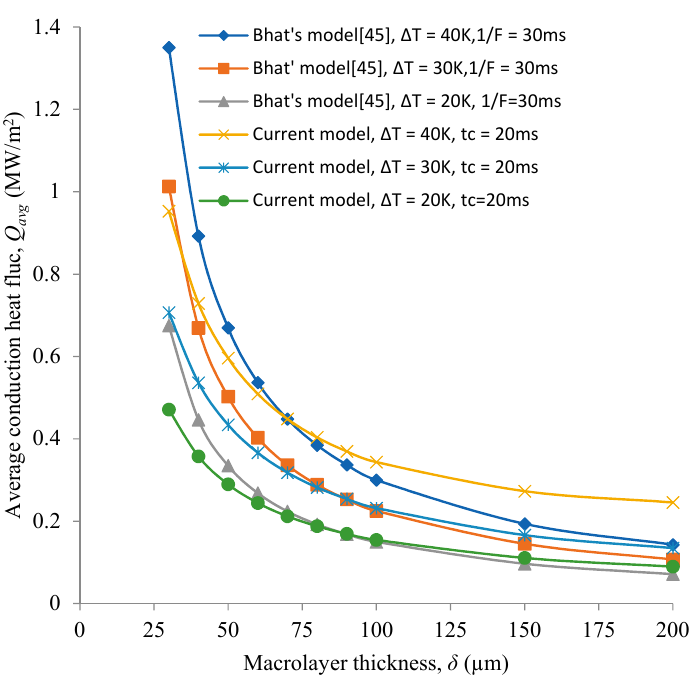
Figure 6. Prediction of average heat flux on macrolayer thickness ( t c = 20 ms, 1/F = 30 ms).